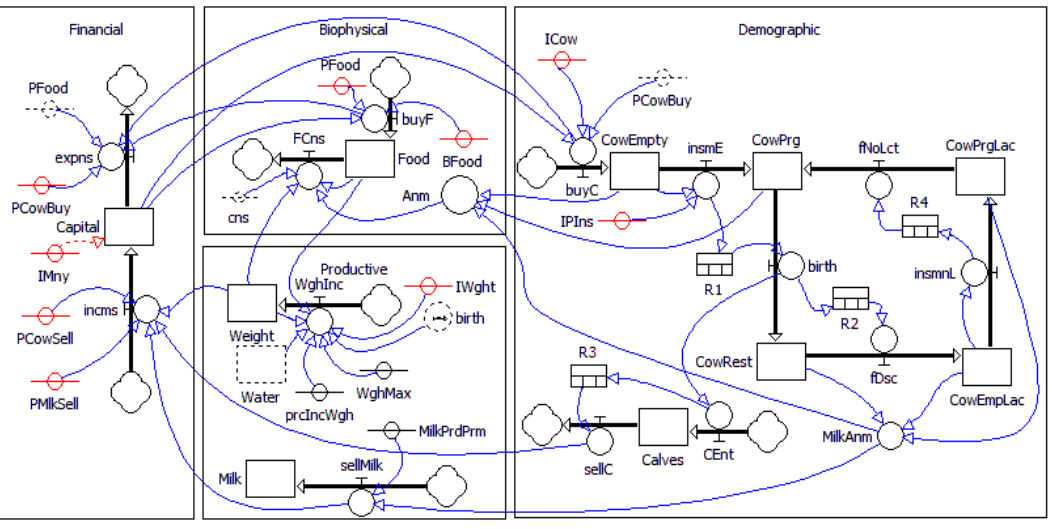
Figure 2. The simulation model in the flow-level language